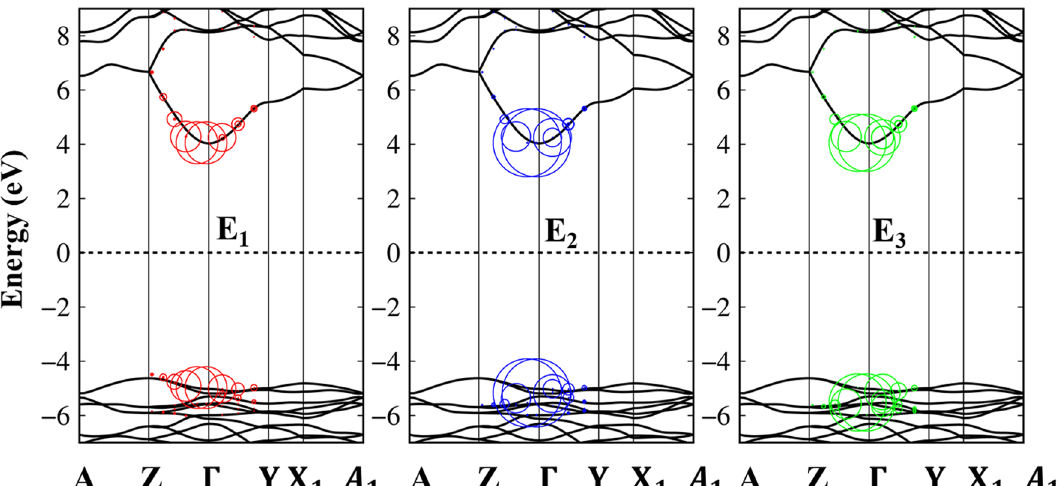
Figure 5. The exciton wave functions of Li 2 SiO 3 compound are plotted as a fat-band structure. The red, blue and green circles indicate E 1, E 2 , E 3 exciton peaks in the imaginary-part of dielectric functions. The black lines in the back- ground indicate the Quasi-particle band structure and the Fermi energy is set to zero at the middle of conduction and valence